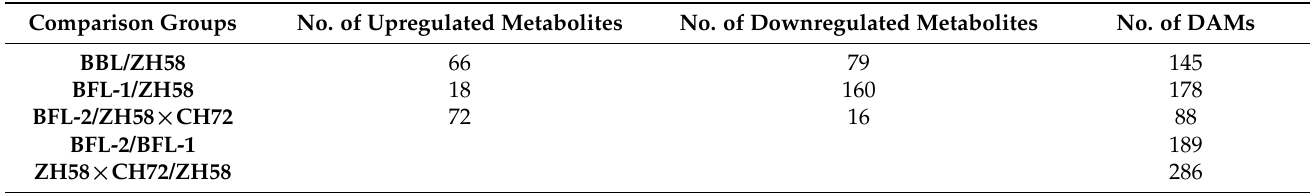
Figure 3. KEGG pathway enrichment analysis of DEPs in BBL/ZH58 ( A ), BFL-1/ZH58 ( B ), and BFL-2/ZH58 × CH72 ( C ). Table 3. Summary of the number of DAMs in the different comparison